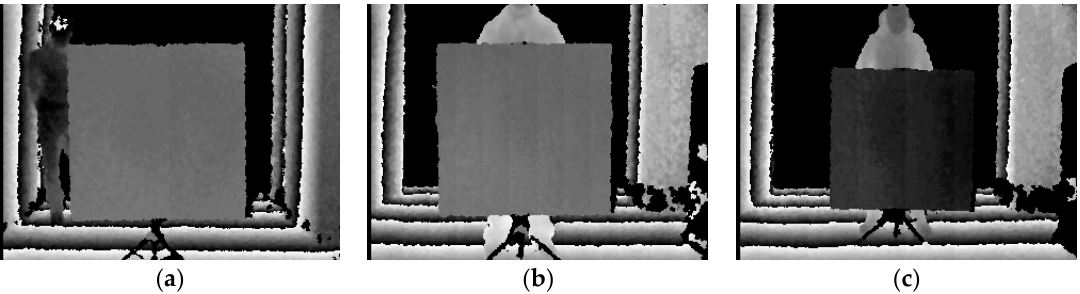
Figure 5. ( a ) Z = 1.8 m indoor depth map result; ( b ) Z = 1.8 m daytime outdoor depth map result; and ( c ) Z = 2.2 m night outdoor depth map result.